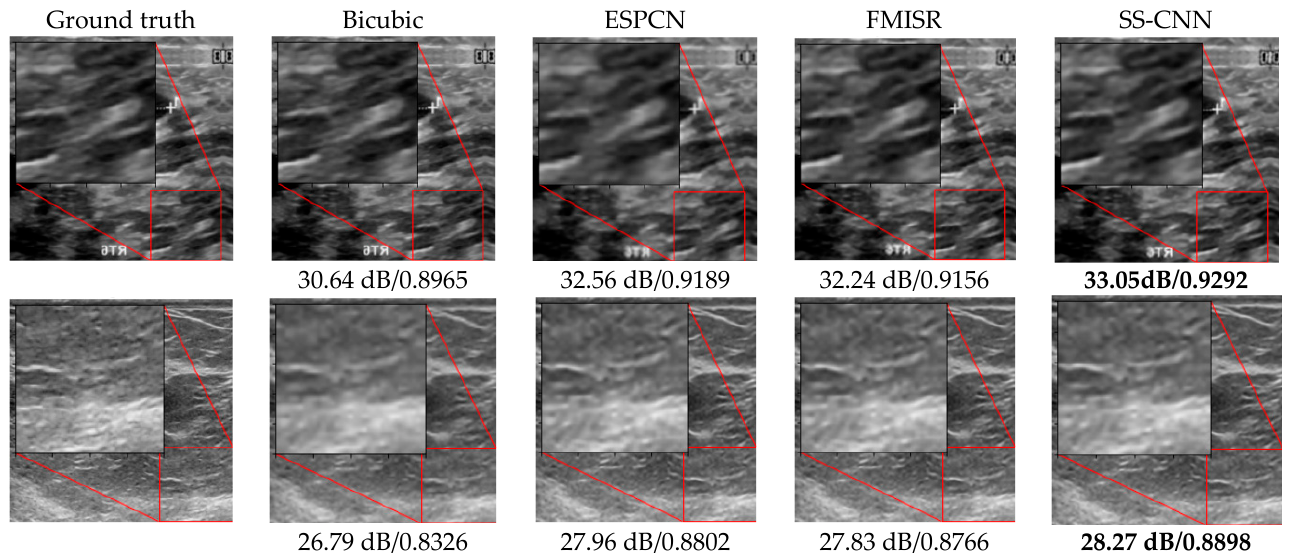
Figure 6. Ground truth HR image and reconstructed HR images generated from various reference methods including the proposed model. PSNR and SSIM values are shown below each sub-figure. Top row (Dataset A), and bottom row (Dataset B). Bold characters represent the highest value of PSNR and SSIM.